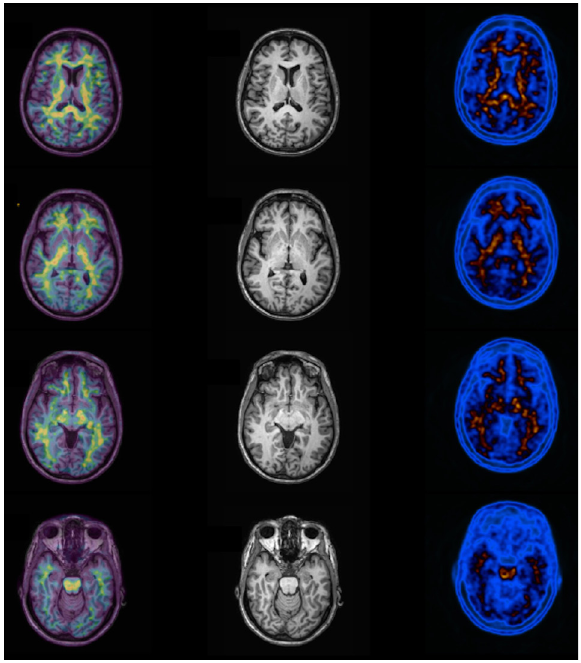
Figure 7. Abnormal PIB PET imaging a patient with confirmed clinical diagnosis of Alzheimer disease. Note marked uptake in the frontal and parietal cortex, with poor visualization of white matter uptake. Right col- umn is the PIB images, middle the MRI and the left column is seen the fused images (PIB +